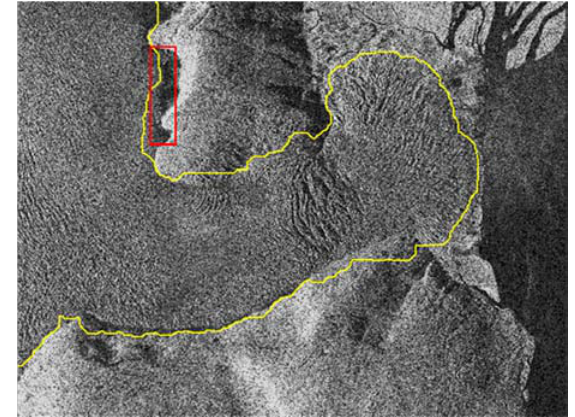
Fig.9. Feature relevance of the selected 11 features (Std: standard deviation, M: mean, Con: contrast, Cor: correlation, En: energy, Homo: homogeneity).